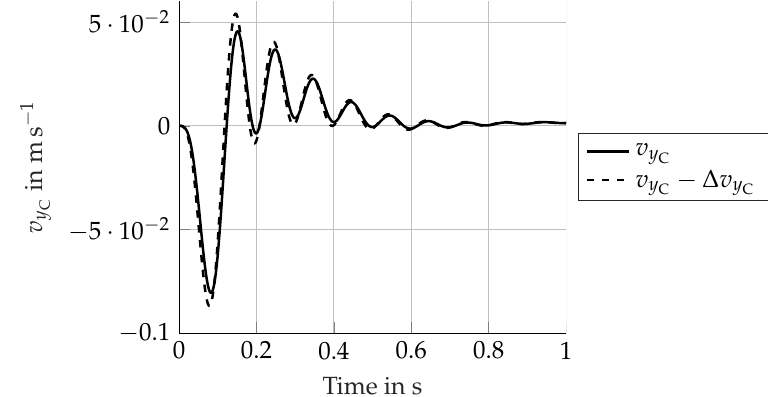
on wobble damping. In the dotted curve only ∆ v y C and ∆ M z (with Equation (9)) are compensated. C